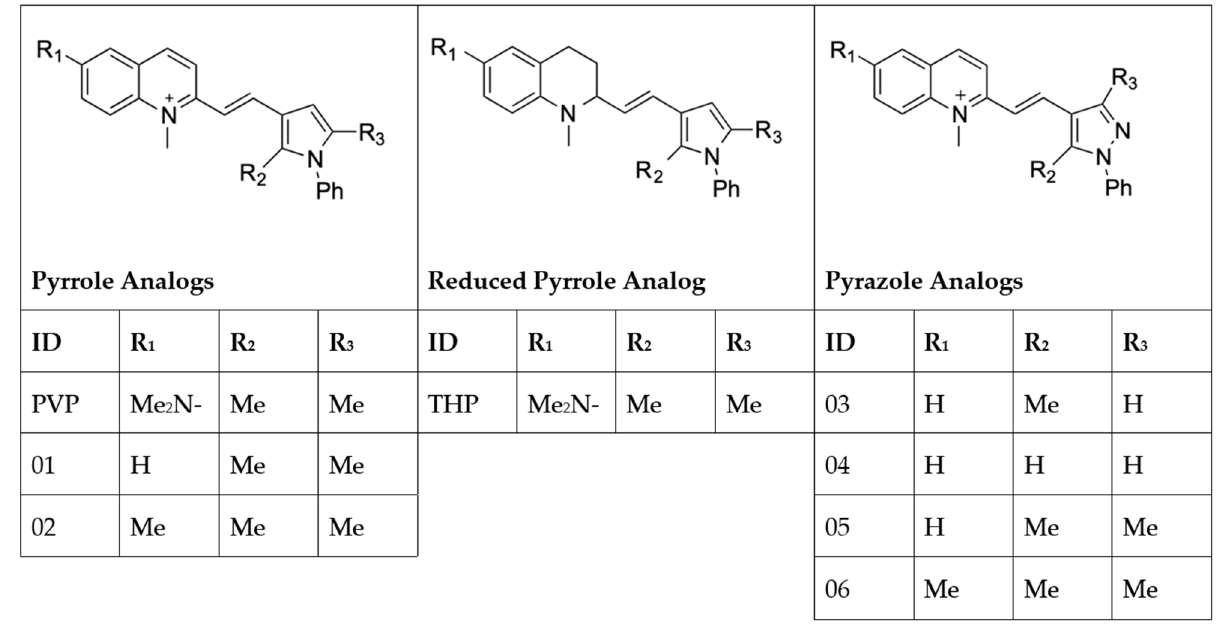
Figure 1. Chemical structures of pyrvinium pamoate and its analogs.